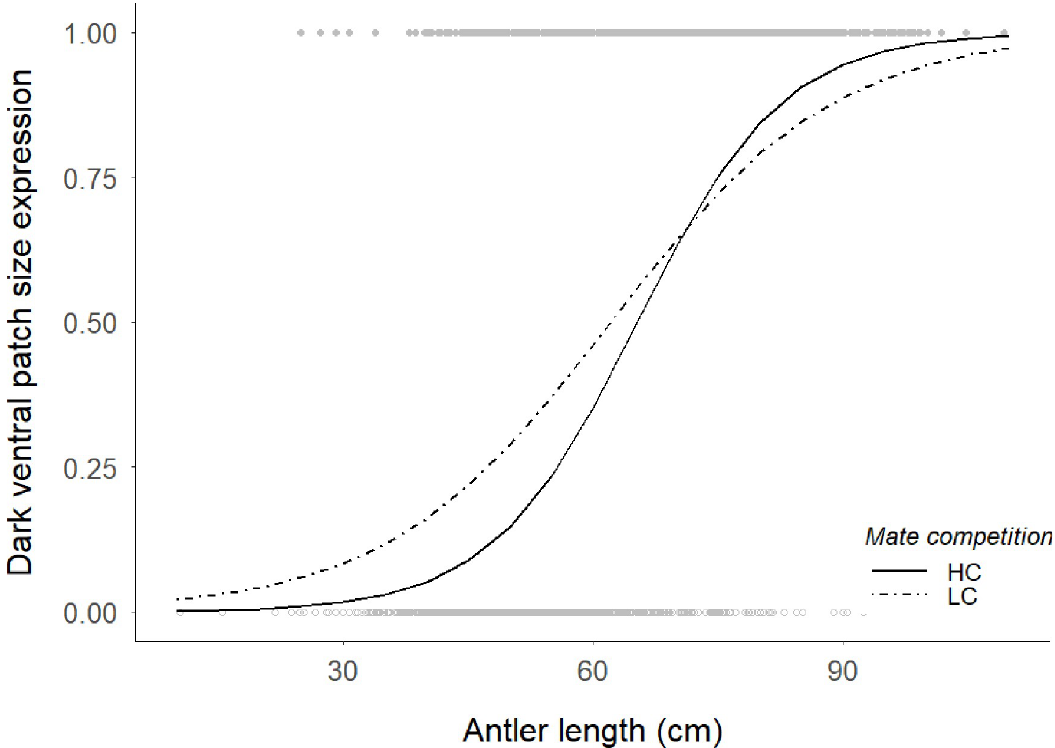
Fig 4. Predictions of the model of Table 2 on the dark ventral patch expression probability against antler length (cm) from populations with two levels of male-male sexual competition for mating opportunities (high competition, HC solid line, and low competition, LC dashed line). Points are raw, untransformed data for the dark ventral patch expression (1 = HTE: grey filled points; 0 = LTE, grey open points).